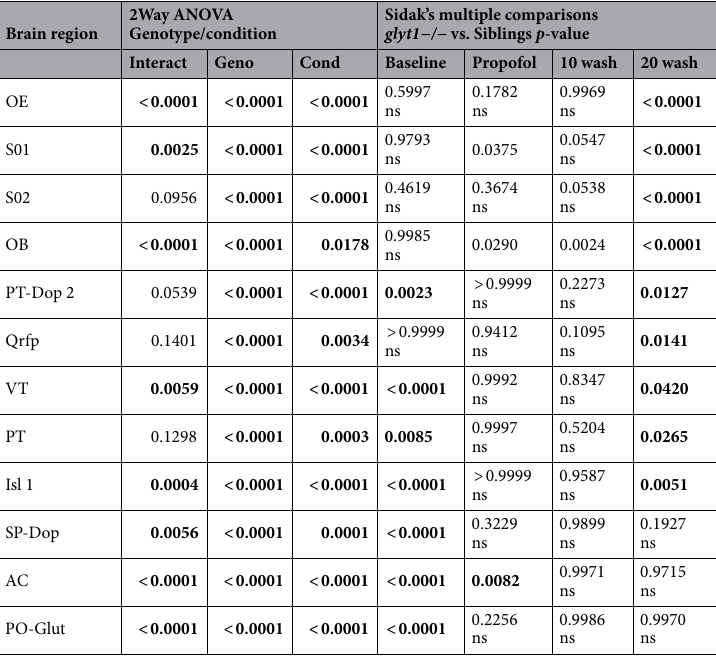
Table 2. Brainwide differences between glyt1−/− mutant and sibling larvae are most pronounced in baseline and 20 min. wash conditions. For the twelve brain regions shown in Fig. 7, 2way ANOVA p -values for interaction, genotype, and condition are shown in columns 2–4 are followed by p -values for Sidak’s multiple comparisons of glyt1−/− mutants and siblings across the four conditions in columns